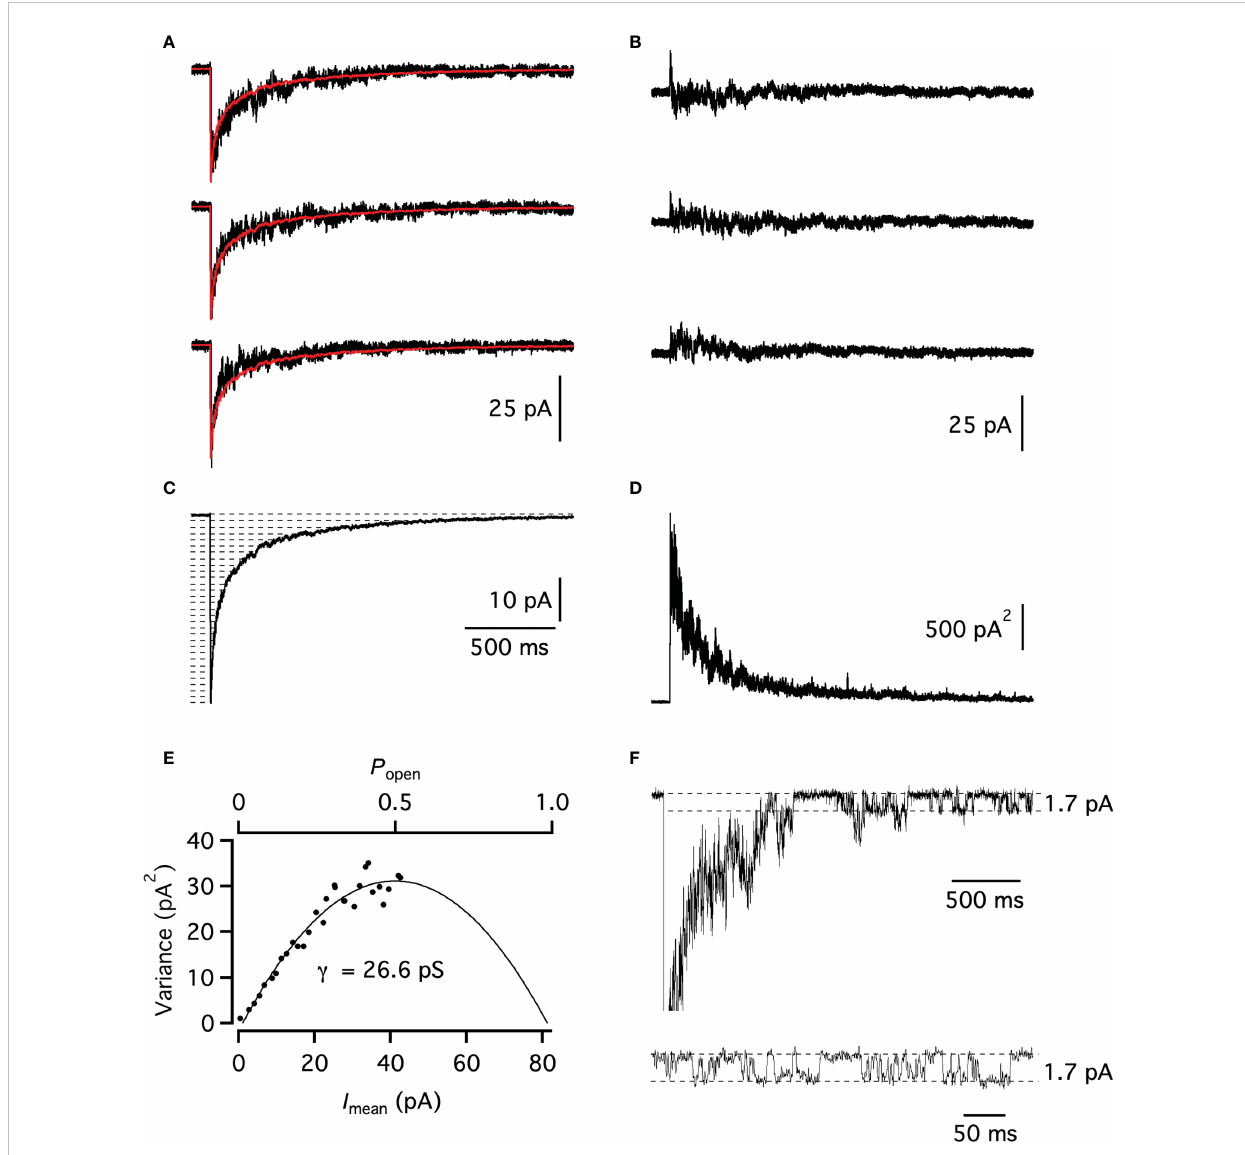
FIGURE 4 Non-stationary noise analysis of GABA-evoked responses in an AII nucleated patch. (A) Three individual records obtained by brief (~2 ms) pulses of GABA (3 mM) to an AII nucleated patch ( V hold = -60 mV, E Cl ~ 0 mV) with the ensemble mean current (average of 47 trials) overlaid (red). (B) Associated difference currents generated by subtracting the ensemble mean current from the individual responses in (A) . (C) Mean current of all GABA-evoked responses in the ensemble. Broken horizontal lines indicate amplitude intervals used for binning mean current and variance (see Materials and methods). (D) Ensemble current variance (without binning) for the GABA-evoked responses, calculated from the difference currents (as in (B) ). (E) Plot of the ensemble current variance (D) versus mean current ( (C) ; after binning). Time period used for the variance versus mean plot corresponds to data points from the peak to the end of the decay phase of the mean waveform. The data points were fi tted with eqn (3). (F) Current response evoked by a brief (~2 ms) pulse of GABA (3 mM) to an AII nucleated patch. The peak of the inward current has been truncated for better visualization of GABA-evoked single-channel gating during the late decay phase. Inset (bottom) shows single-channel gating displayed at an expanded time scale. Broken lines indicate baseline current and inward current during channel opening (as